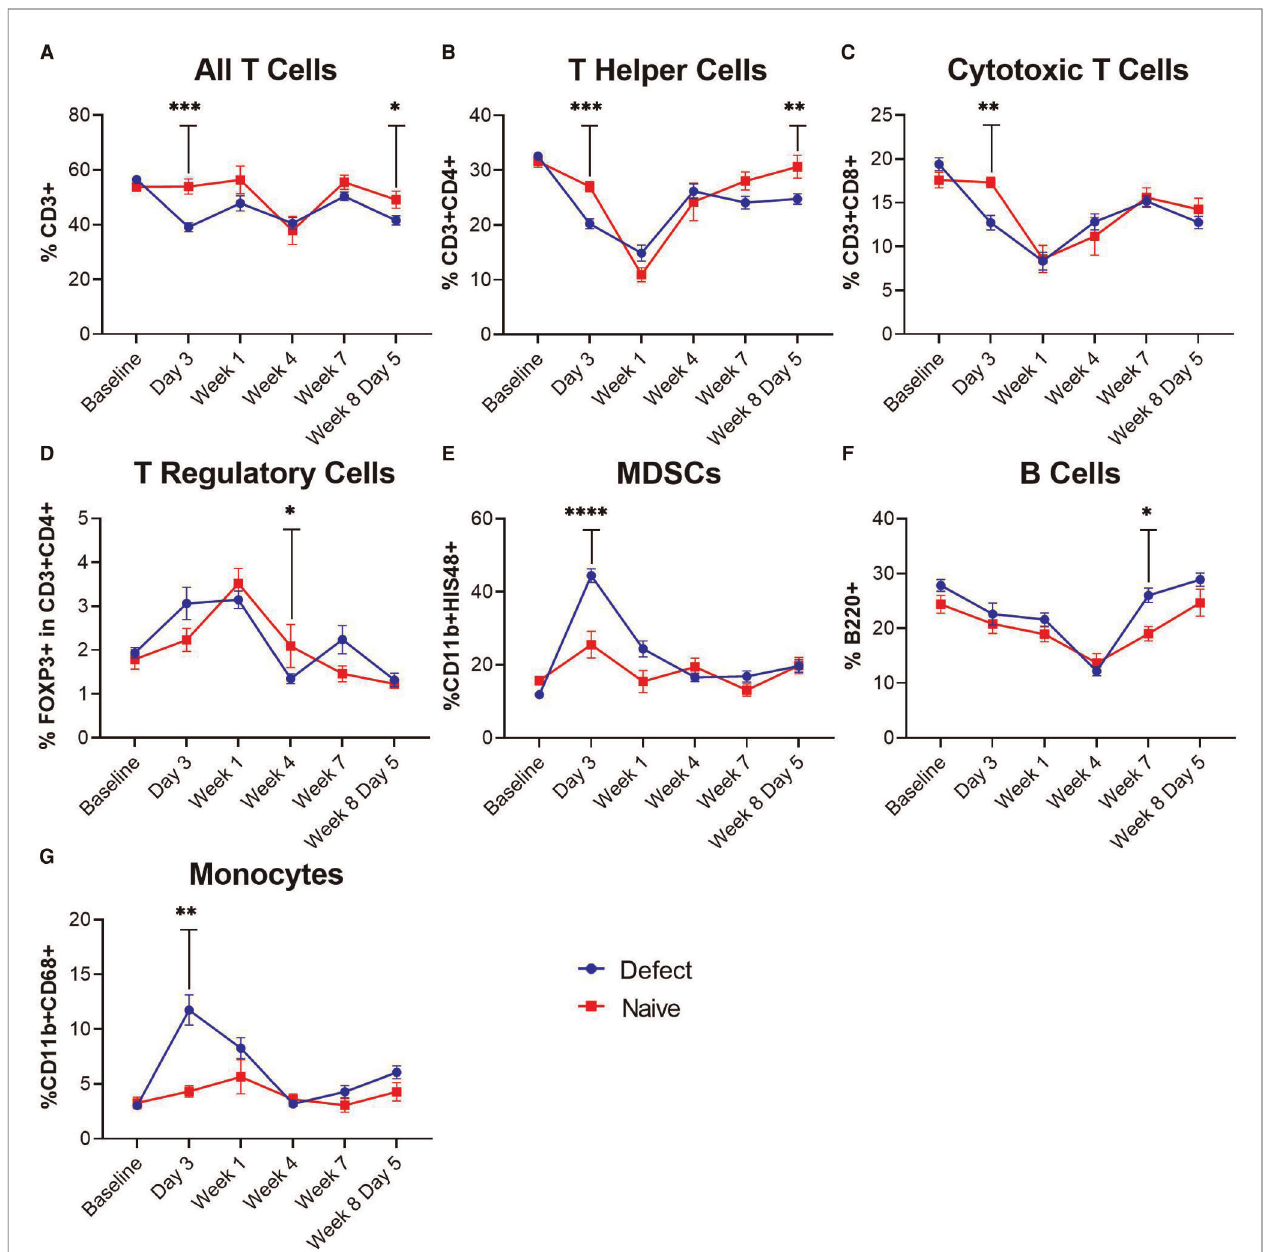
FIGURE 2 | Characterization of circulating immune cells after injury (Day 0) and treatment (Week 8). ( A – G ) Signi fi cant changes in immune cell populations were observed in rats after injury. T cells, T helper cells, and cytotoxic T cells were signi fi cantly decreased in injured rats ( A – C ), while MDSCs and monocytes were signi fi cantly elevated ( E,G ). Data are mean±SEM, n =7 to 13 per group. * P <0.05; ** P <0.01; *** P <0.001; **** P <0.0001 as